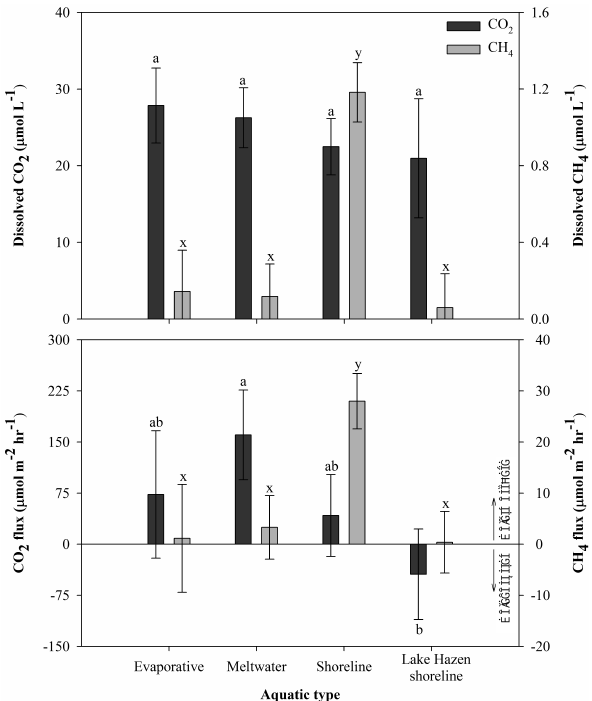
Figure 3. Mean ( ± SE) dissolved carbon dioxide (CO 2 ) and methane (CH 4 ) concentrations and fluxes during the 2005 and 2007–2012 growing seasons (June–August) from four different freshwater types in the Lake Hazen watershed. Letters denote sta- tistical differences between ecosystem types for each gas (linear mixed model; α = 0.05; see